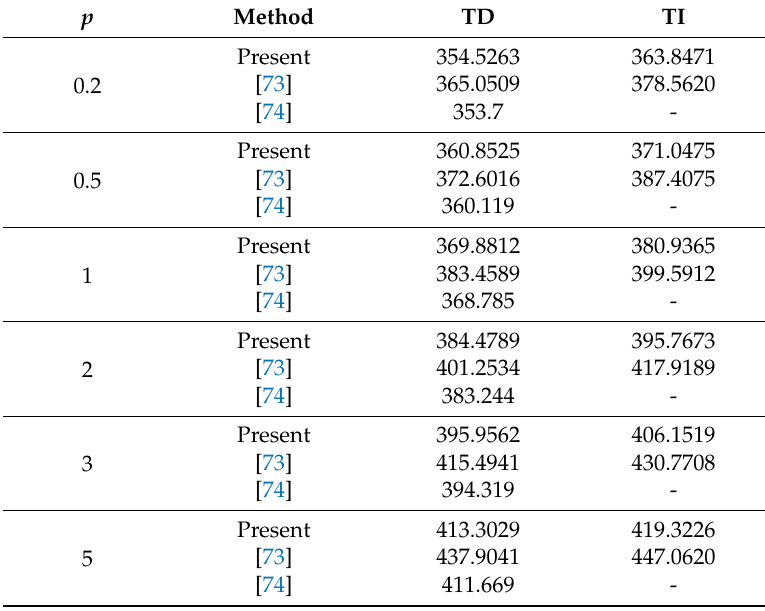
Table 2. Buckling temperatures T cr (in K) as computed by the Generalized Differential Quadrature (GDQ) approach, compared to predictions by [73,74] for a Functionally Graded Material (FGM) cylindrical shell, with temperature-dependent (TD) or temperature-independent (TI) material properties considering H = 1/400 and L 2 / H =